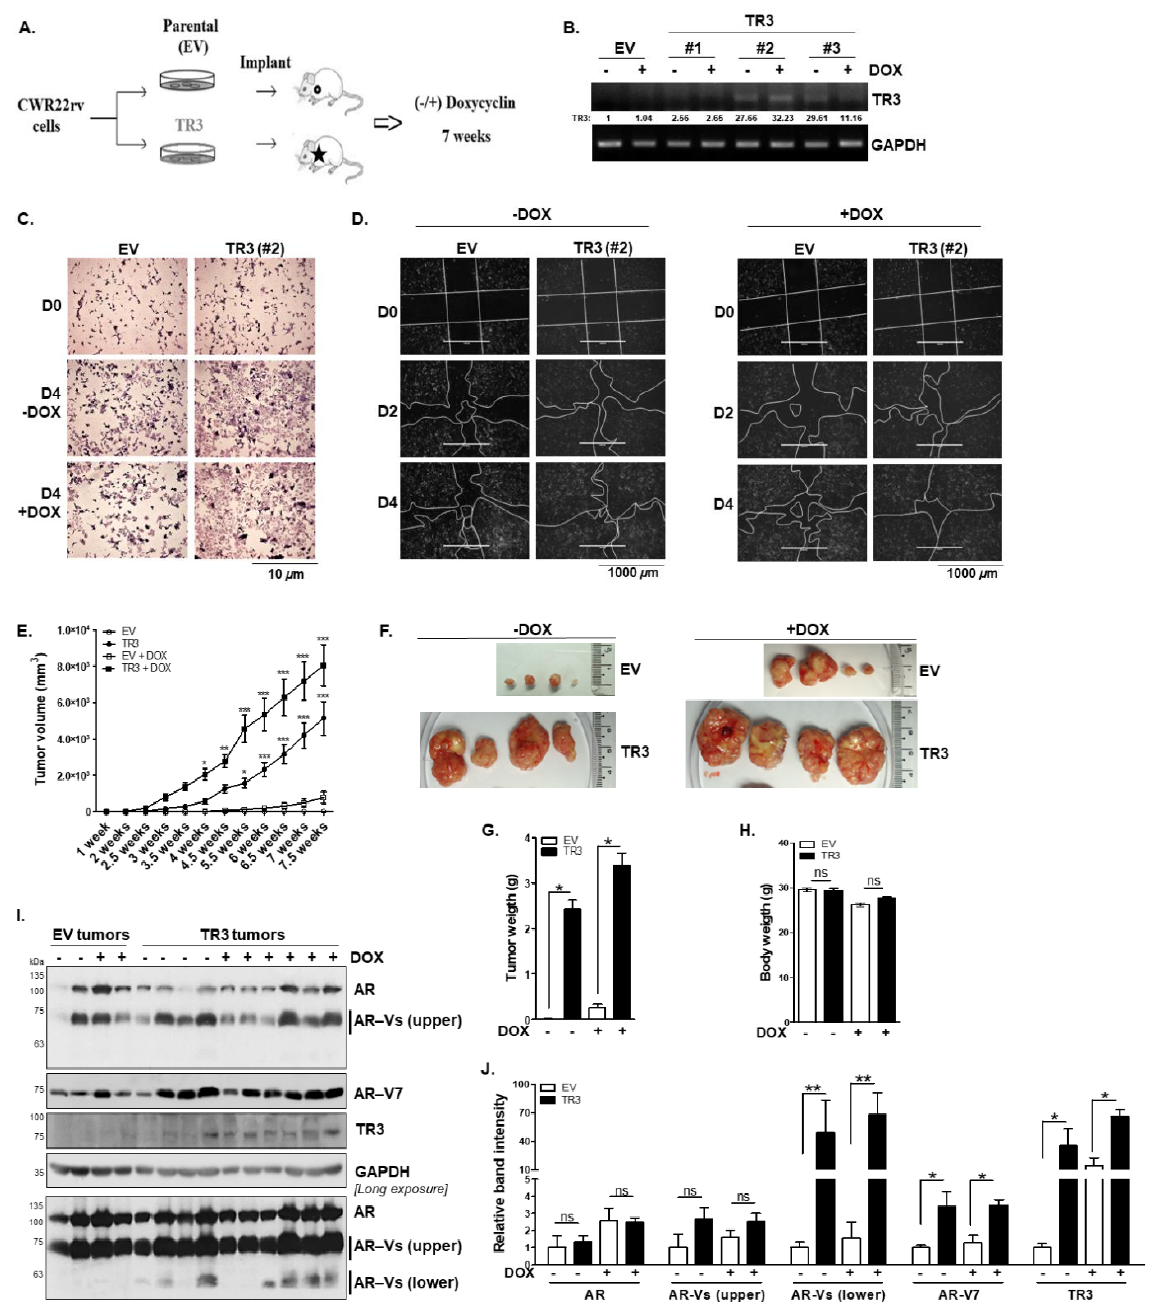
Figure 7. TR3 overexpression enhances in vivo tumorigenesis of androgen-independent prostate cancer cells. ( A , B ) Xenograft mouse model and establishment of a stable cell line overexpressing TR3. Schematic presentation of the experimental set-up for CWR22Rv1 xenograft mouse models ( A ). RT-PCR analysis showing TR3 expression in the inducible TR3-overexpressing CWR22Rv1 cell sublines (#1, #2, and #3) and the control (EV) treated with 2 µg/mL doxycycline (DOX) or vehicle ( B ). Values below gels indicate the relative band intensity of TR3 normalized to GAPDH. ( C , D ) A stable cell line overexpressing TR3 shows an increase in cell proliferation and mobility compared to the control (EV). Cell viability of stable EV and TR3 (#2) sublines ( C ). Cells were seeded for 12 h before treating DOX (D0), and maintained for 4 (D4) days in the absence or presence of 2 µg/mL DOX. Cells were then stained with crystal violet and imaged using ZEISS microscopy at 10X magnification. Scratch wound-closure assay of stable EV or TR3 (#2) sublines ( D ). Scratch-wounds were generated (day 0, D0) and the wound distances were monitored for 2 (D2) and 4 (D4) days in the absence (( D ),